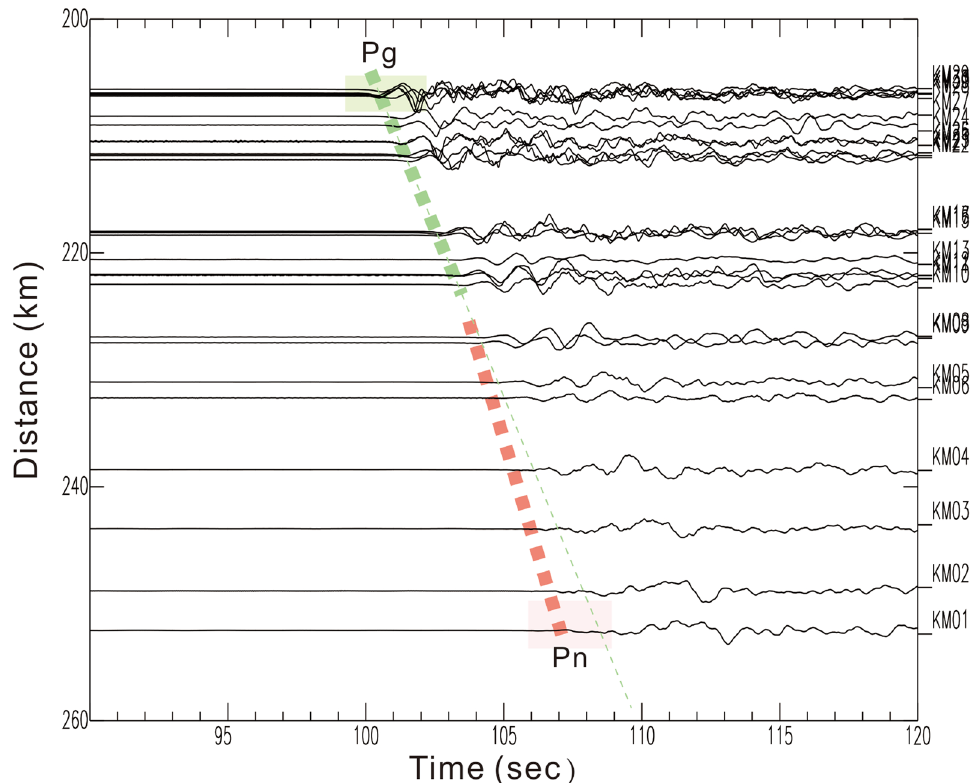
Fig. 8 Waveform comparison between Pg and Pn as generated by Event 3. The seismic amplitudes of Pg (green) are significantly larger than those of Pn